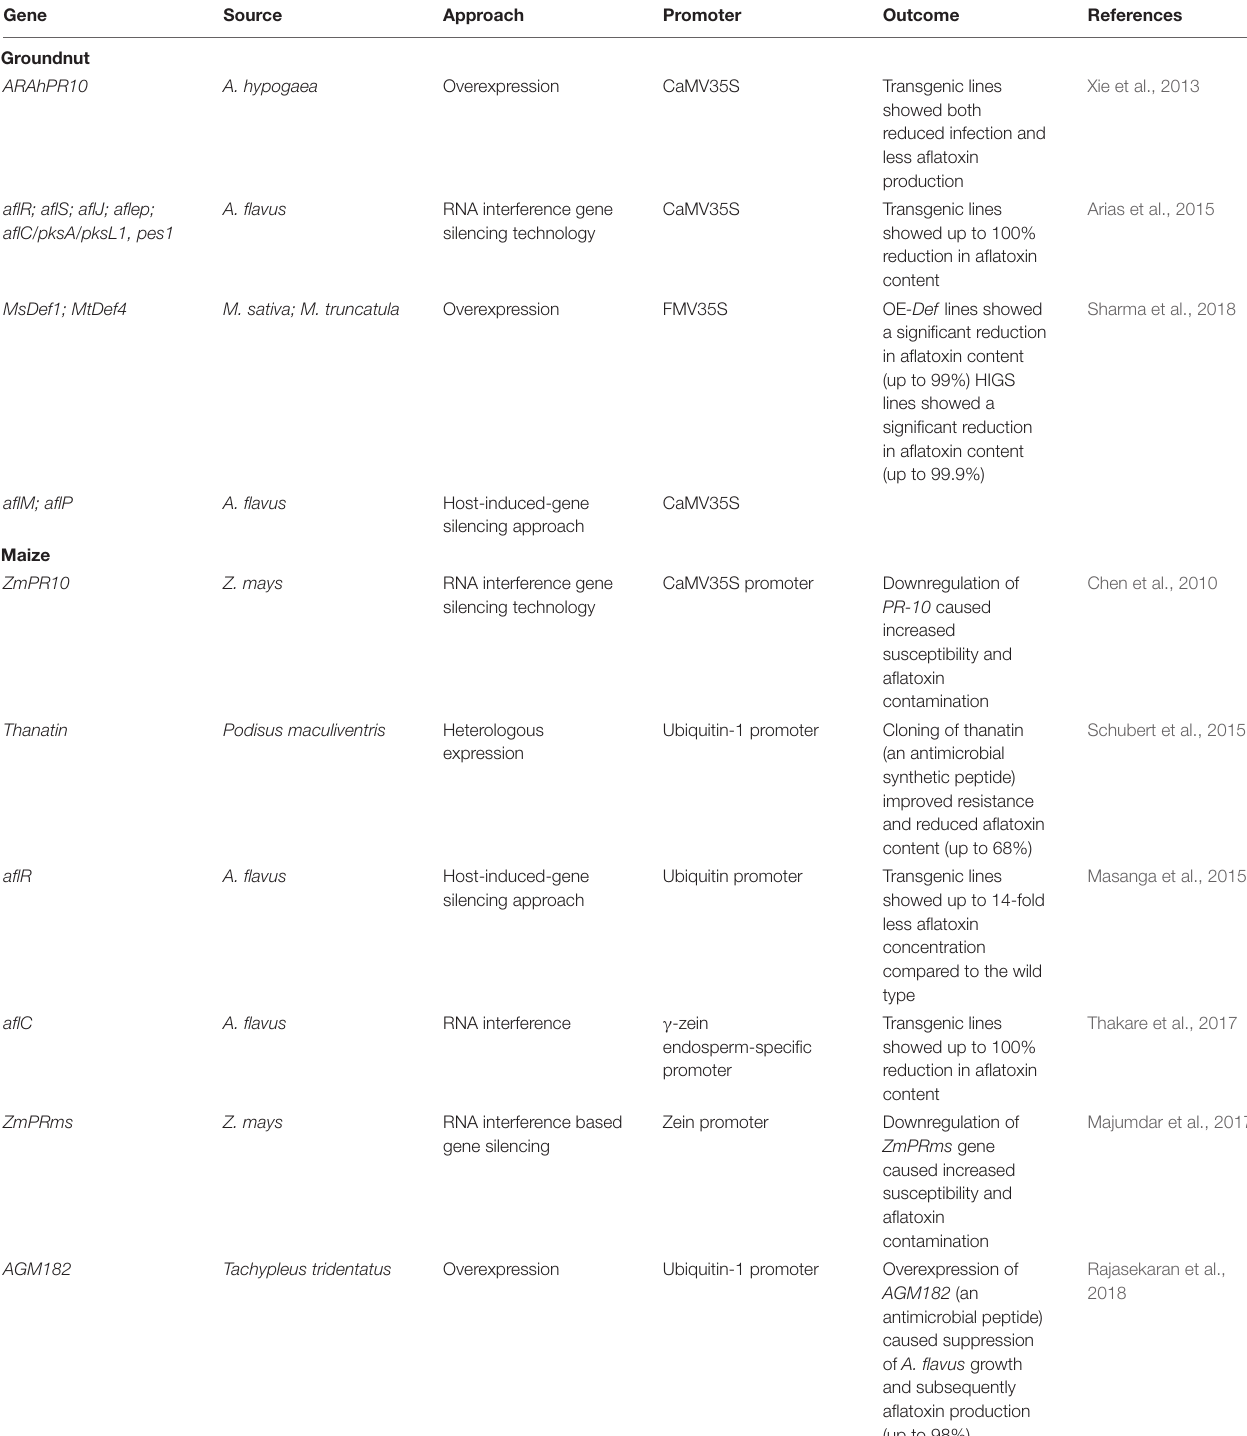
TABLE 4 | A summary of some overexpression, RNAi and host-induced gene silencing studies in groundnut and